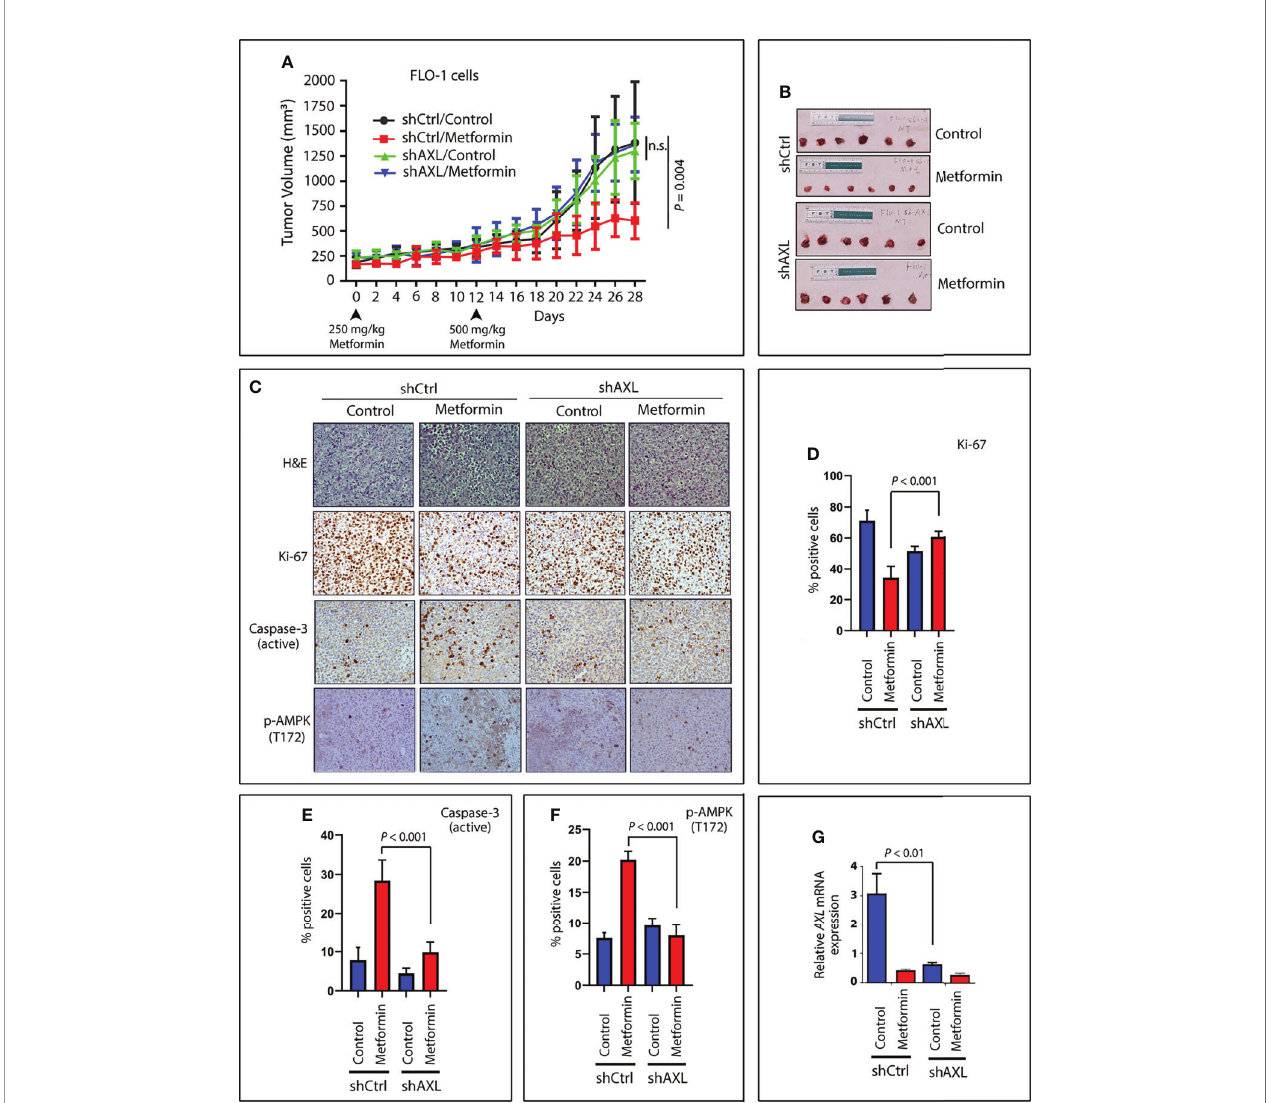
FIGURE 8 | Expression of AXL sensitizes tumors to metformin in a xenograft mouse model. Four groups (10 mice per group) of Rag2 mice were injected on both hip fl anks with FLO-1-shCtrl (two groups, no treatment and treatment) or FLO-1-shAXL cells (two groups, no treatment and treatment). When tumors reached a size of approximately 250 mm 3 , the mice were randomized and not treated or treated by oral gavage with metformin (250 mg/kg) daily for 12 days. The metformin dose was then increased to 500 mg/kg daily until the end of the experiment (day 28). (A) Treatment with metformin signi fi cantly reduced tumor size in shCtrl cells ( P = 0.004) relative to nontreated tumors. Knockdown of AXL expression (shAXL cells) completely abrogated the suppressive effect of metformin on tumor growth. (B) Representative images of endpoint xenografts depicting the effect of metformin on tumor size. Images (200x magni fi cation) of H&E staining (C) and IHC analysis for expression for Ki-67, a marker of proliferation (C , D) ; cleaved caspase-3, a marker of apoptosis (C , E) ; and p-AMPK (T172), a marker of autophagy (C , F) in representative endpoint tumors of all metformin-treated and non-treated animal groups. (G) Real-time PCR data depicting relative AXL mRNA expression in representative endpoint tumors of all the animal groups. n.s., not signi fi